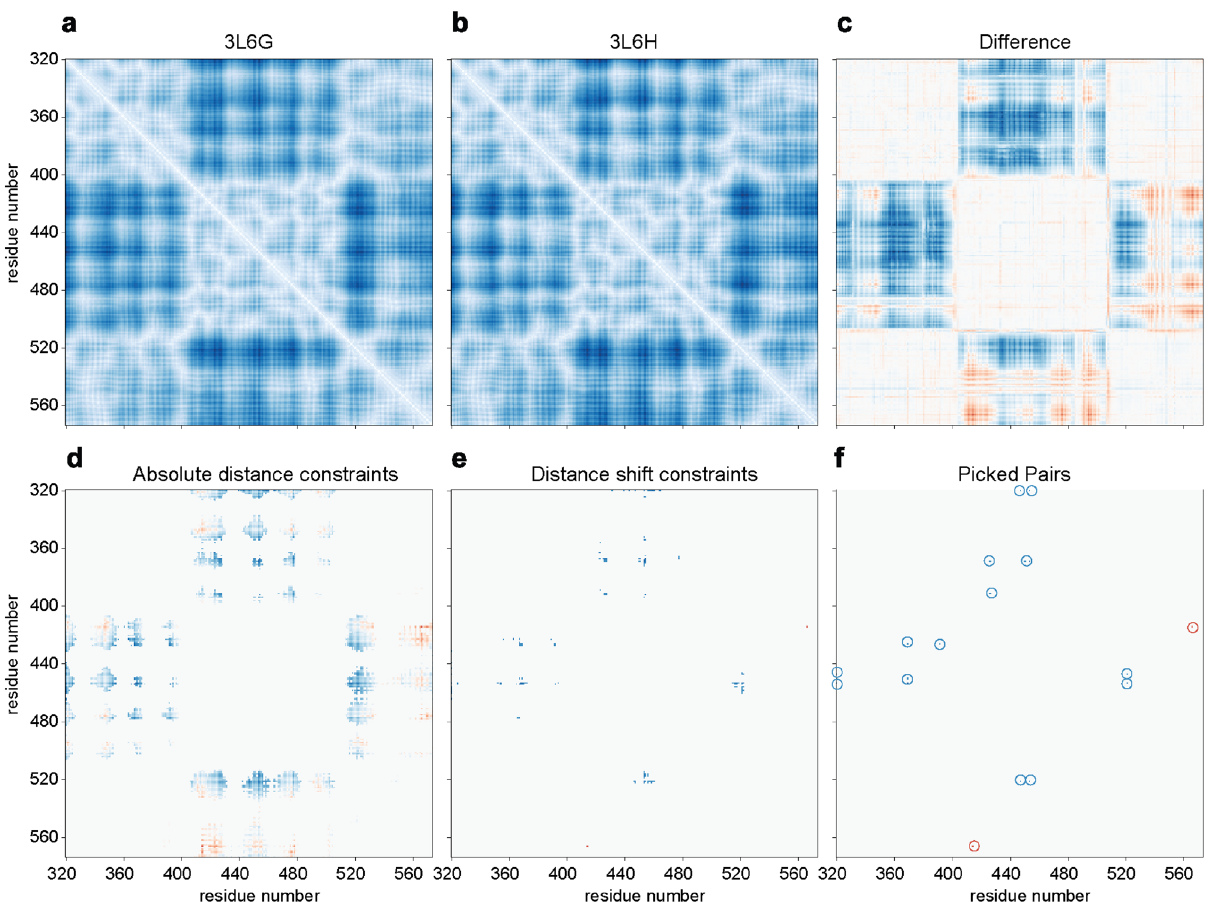
pairs with a distance change smaller than 8 Å are filtered out. Panel ( f ), the same as panel e but now all residues that are less than 60% surface-exposed are filtered out; circles are drawn around pairs/clusters to increase